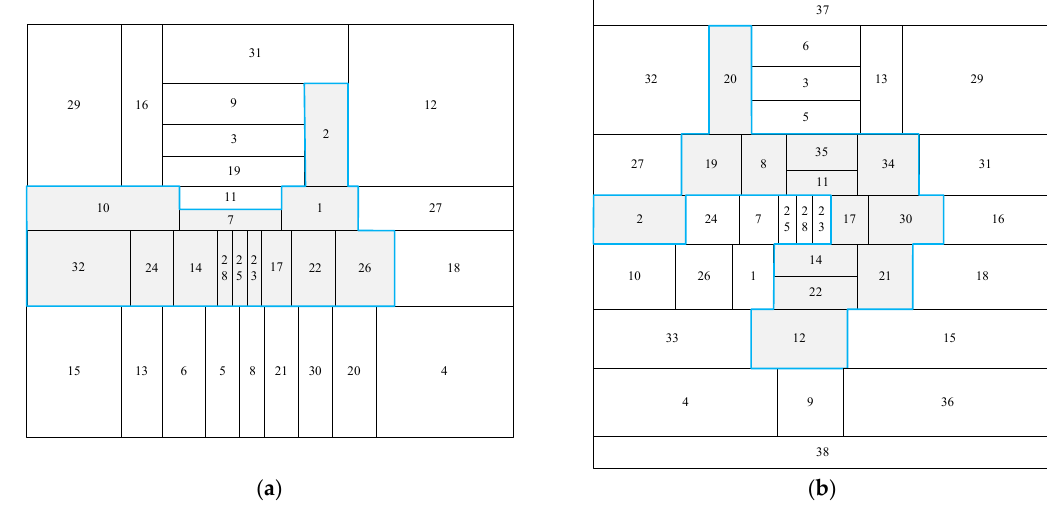
Figure 15. Layout configurations. ( a ) SC30; ( b ) SC35.